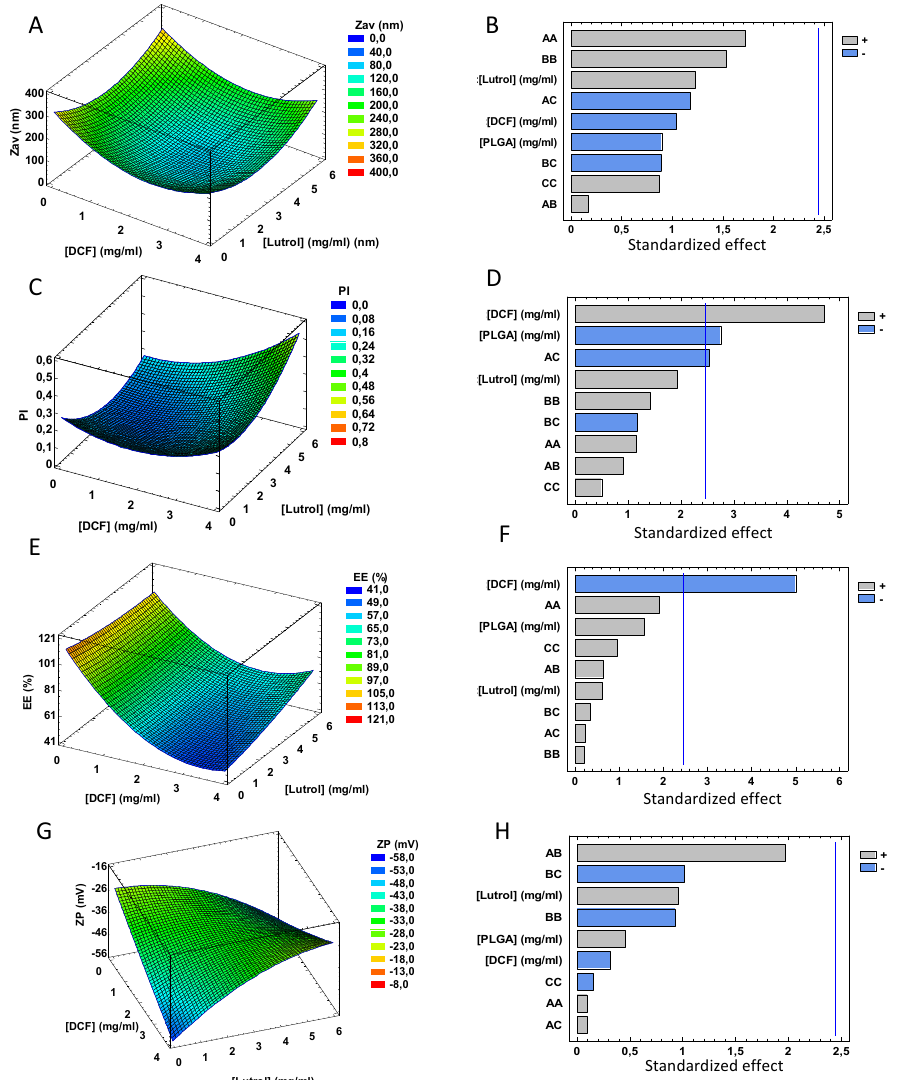
Figure 1. Results of the DoE of DCF NPs. ( A , C , E , G correspond to surface responses and B , D , F , H correspond to Pareto diagram). ( A ) Surface response of Z av at a fixed concentration of PLGA (16 mg/mL), ( B ) Standardized Pareto diagram of Z av , ( C ) Surface response of PI at a fixed concen- tration of PLGA (16 mg/mL), ( D ) Standardized Pareto diagram of PI, ( E ) Surface response of EE at a fixed concentration of PLGA (16 mg/mL), ( F ) Standardized Pareto diagram of EE, ( G ) Surface response of ZP at a fixed concentration of PLGA (16 mg/mL) ( H ) Standardized Pareto diagram of